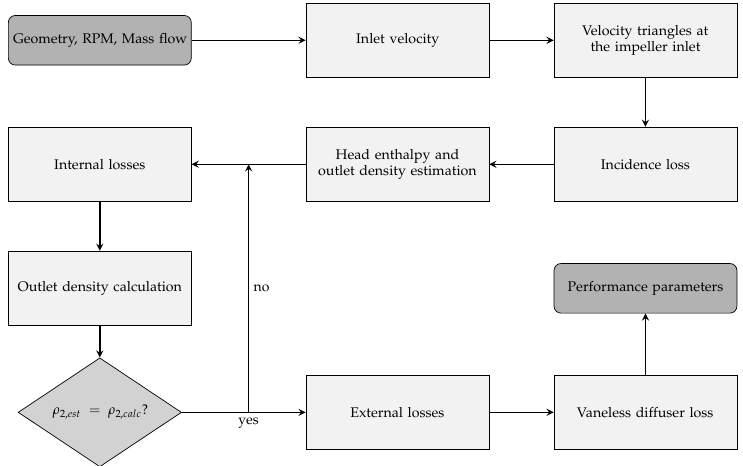
Figure 3. Flowchart of the off-design performance prediction